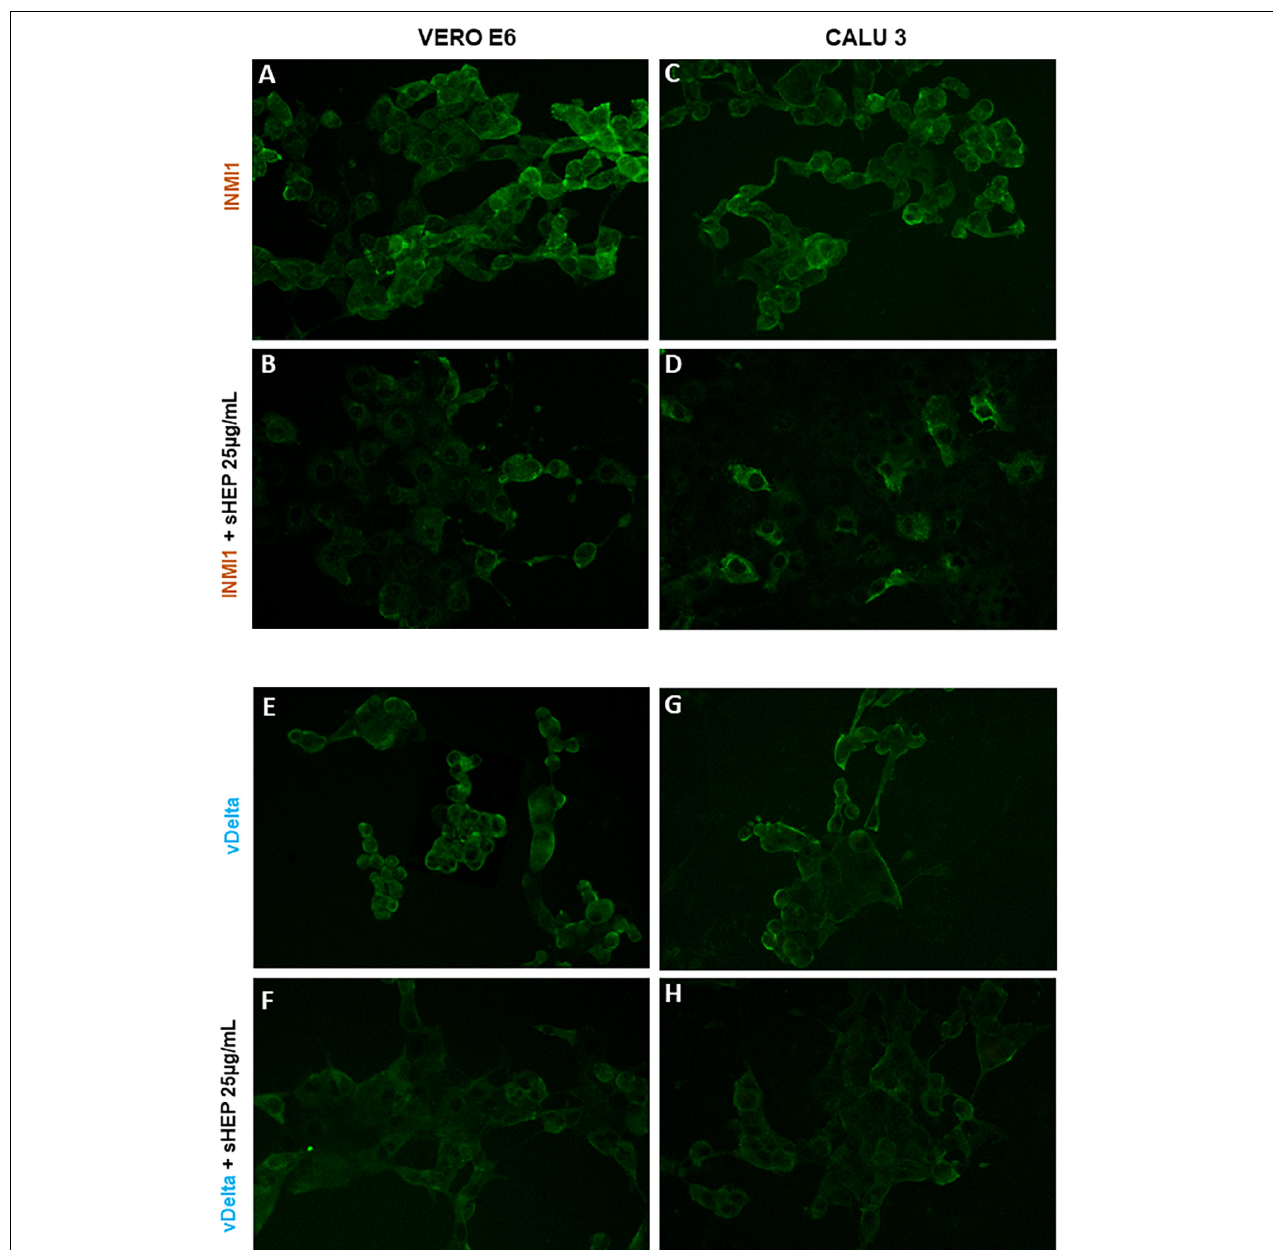
FIGURE 6 | Immunofluorescence staining for SARS-CoV-2 of VERO E6 and GALU 3 cells 48 h post-infection with INMI1 or vDelta and treated with sHEP. Panels (A,C) : VERO E6 and CALU 3 infected with INMI1, respectively; Panels (B , D) show these same cells respectively, infected with INMI1 and incubated with sHEP 25 µ g/mL for 48 h. Panels (E , G) refer to VERO E6 and CALU 3 after 48 h infection with vDelta; Panels (F , H) show the same cells respectively, infected with vDelta and treated with sHEP 25 µ g/mL. The staining with human anti-SARS-CoV-2 antibodies illustrates the difference in fluorescence intensity between cells infected and those infected and then incubated in presence of sHEP. Magnification: